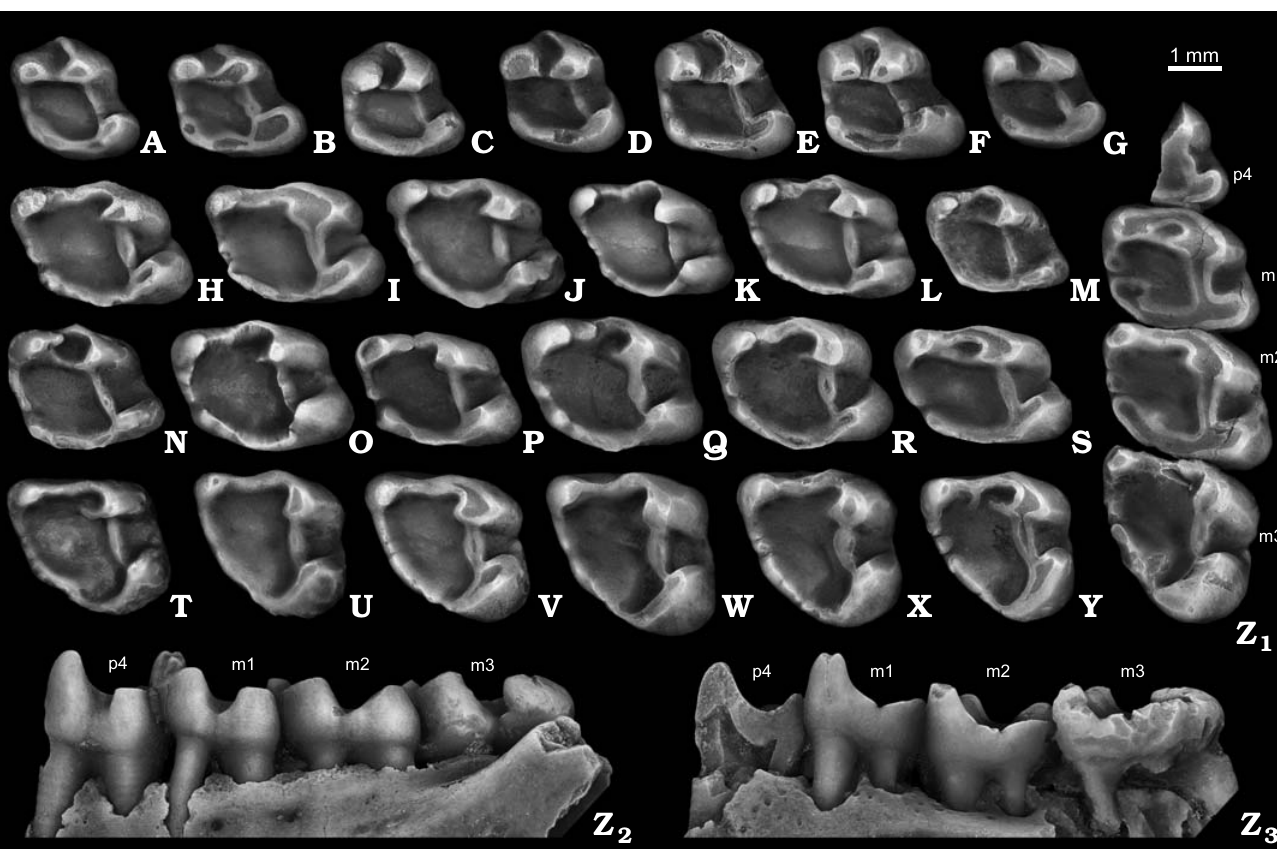
Fig. 7. Ground squirrel Spermophilus praecox sp. nov. from the late Pliocene and Early Pleistocene of southern Ukraine: Kotlovina 2 (A, B, H–J), Kotlovina 3 (C, J–L, U, V, Z), Kry zha novka 2 (T), Yuzhny (M–O), Morskoy (D–G, P–S, W–Y); lower cheek teeth (A–G, p4; H–S, m1–m2; T–Y, m3; Z, p3–m3), in occlusal (A–Z 1 ), labial (Z 2 ), and lingual (Z 3 ) views. A . NMNHU-P 41-5603. B . NMNHU-P 41-5604. C . NMNHU-P 41-5617. D .